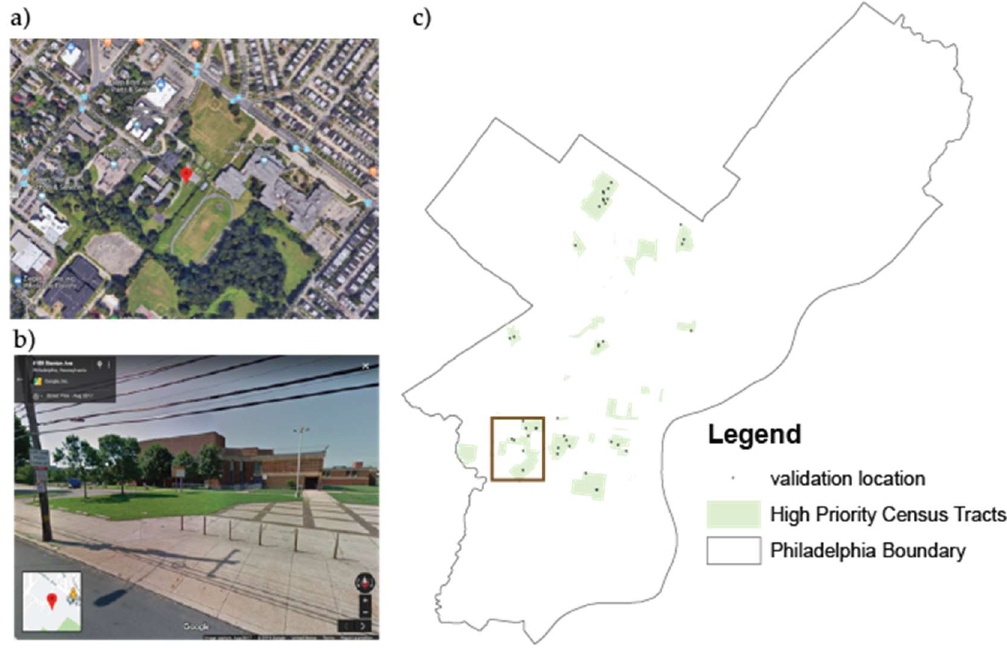
Figure 3. ( a ) sample location for potential siting of GSI feature in Google orthographic imagery; ( b ) StreetView 360° imagery; ( c ) location of all validation points, within previously established high priority census tracts.